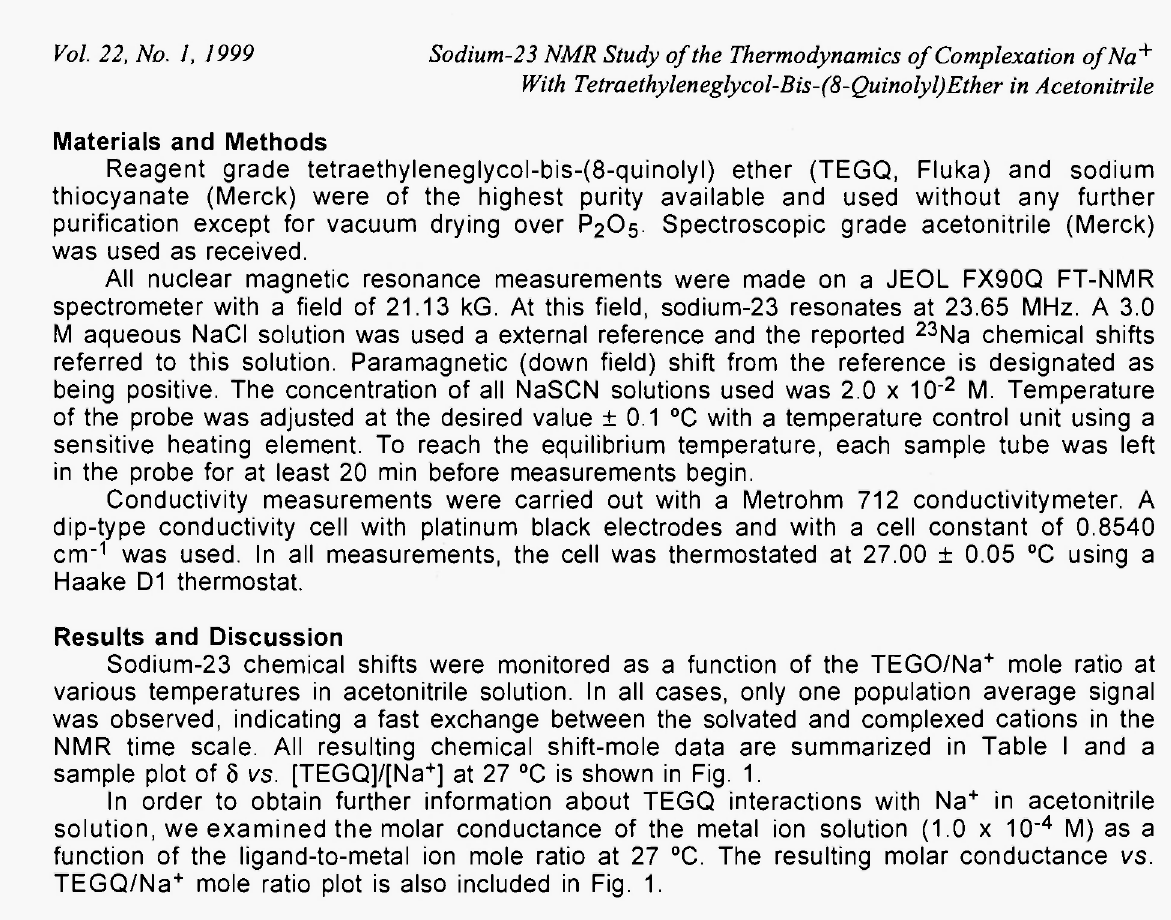
Table I. Sodium-23 chemical shift t/s. TEGQ/Na + mole ratio data in acetonitrile solution